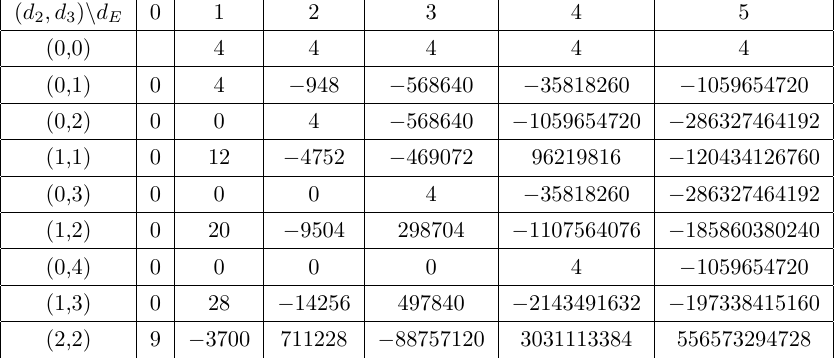
for the genus ( g ) = (0 , 0) . L , g R ( d E ,d 2 ,d 3 )